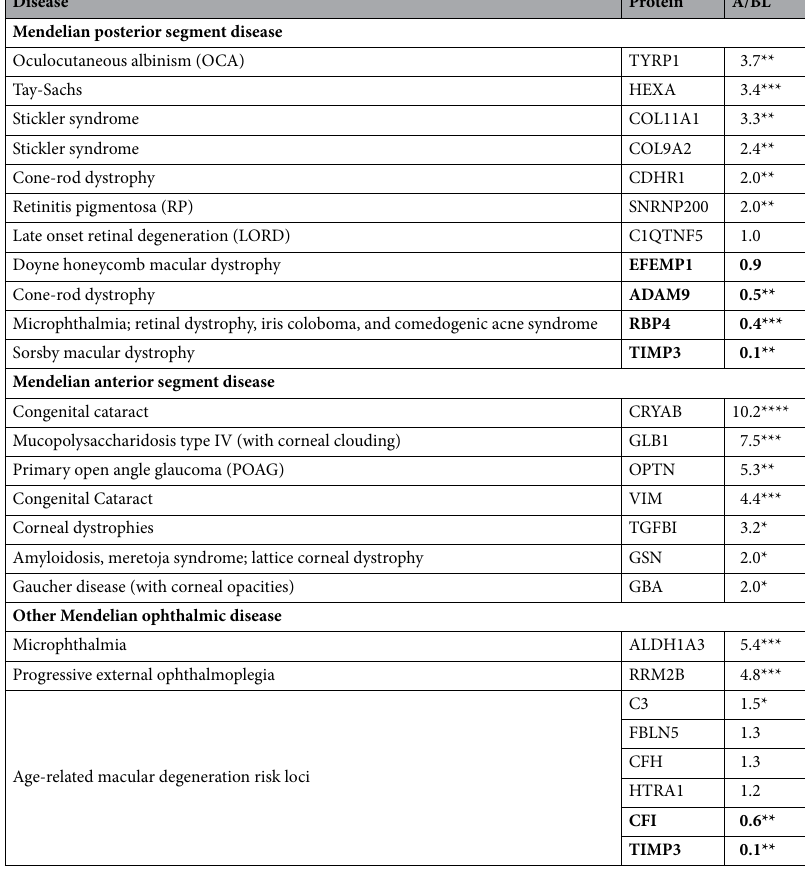
Table 2. RPE directional secretion of proteins encoded by disease genes. A/BL = apical to basolateral ratio; proteins are listed from highest to lowest A/BL within each category. Bold highlights proteins with more basolateral than apical secretion. P-values were calculated with a two-tailed student’s T-test with a Benjamin- Hochberg adjustment. P-value < 0.05 (*), < 0.01 (**), < 0.001 (***), < 0.0001 (****), or > 0.05 (non-significant, no